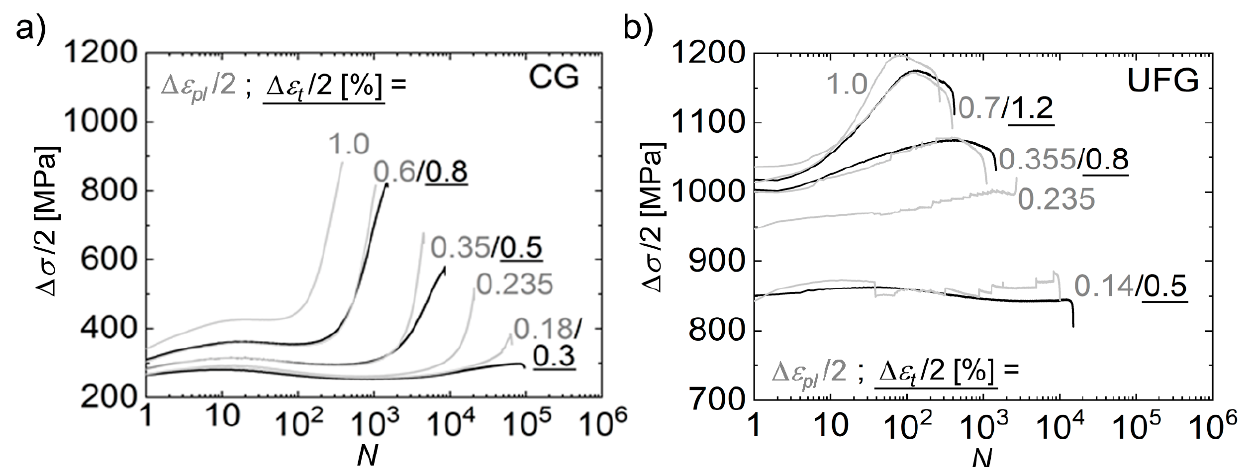
Figure 3. Cyclic hardening/softening curves for ( a ) CG and ( b ) UFG material states. Comparison of total strain-controlled ( ∆ ε t /2) (black curves) and plastic strain-controlled ( ∆ ε pl /2) (gray curves) fatigue tests.